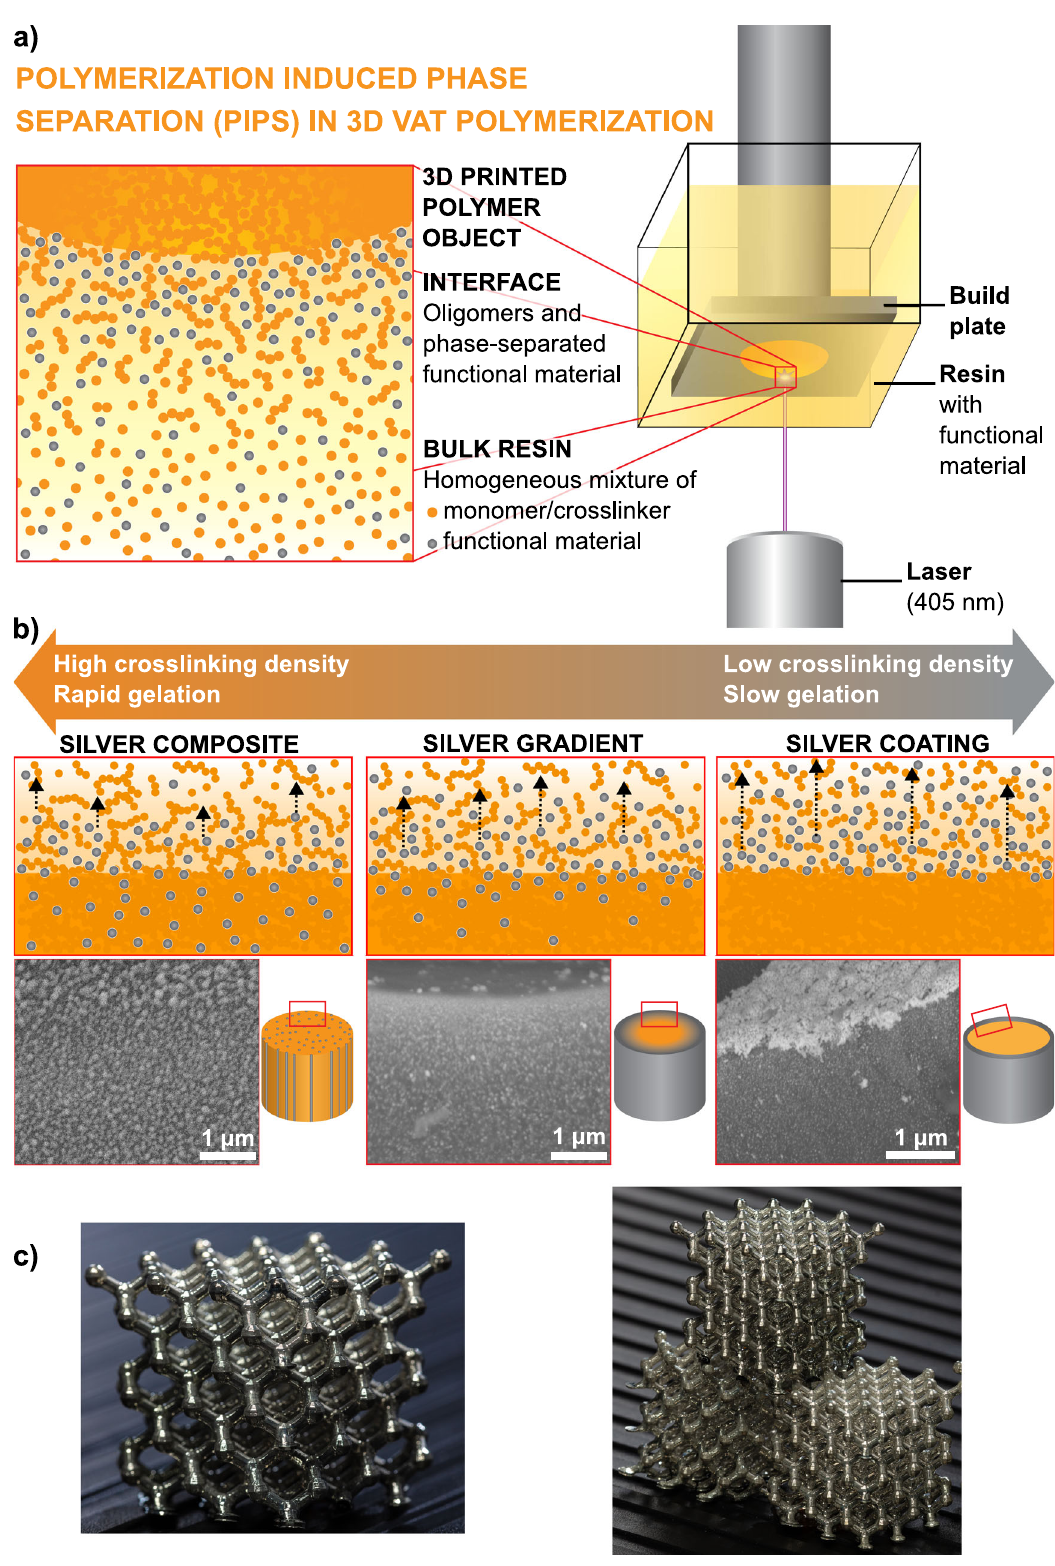
Fig. 1 3D PIPS printing mechanism of functional objects. a Schematic of the phase separation of AgND induced by PIPS (left) depicting the AgND functional material phase separating from the polymer object to the interface during 3D printing using an SLA printer (right). b The tuning of phase separation is controlled with crosslinker molecular weight and percent crosslinker to alter the crosslinking density and polymer gelation rate to yield different morphologies in 3D objects. Representative SEM images are presented to depict the composite, gradient or coating morphologies. c Photographs of PIPS induced 3D printed and sintered Ag coated lattice objects with dimensions of 40 × 40 × 40